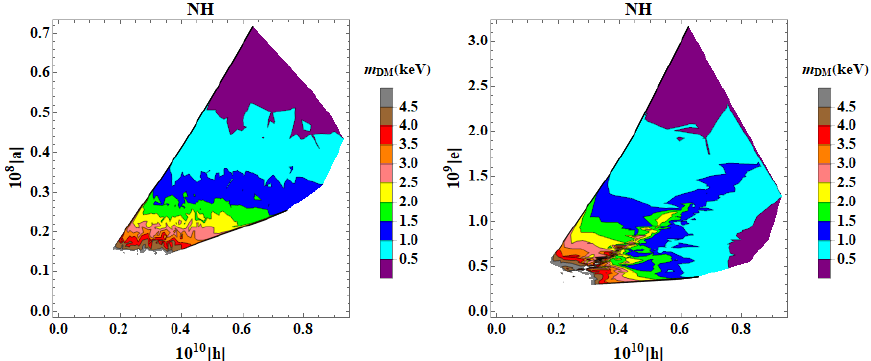
Figure 6 . Variation of di(cid:11)erent model parameters (in eV) with Dark Matter mass as a contour for normal hierarchy. The mass limit as predicted by cosmology is (0 : 4 (cid:0) 50)keV.